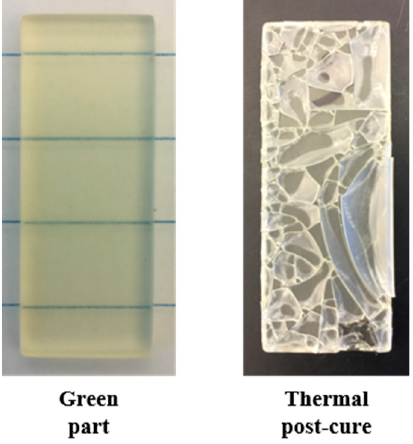
Figure 2. Cracks developed during thermal post-cure of a DA-1 green part.